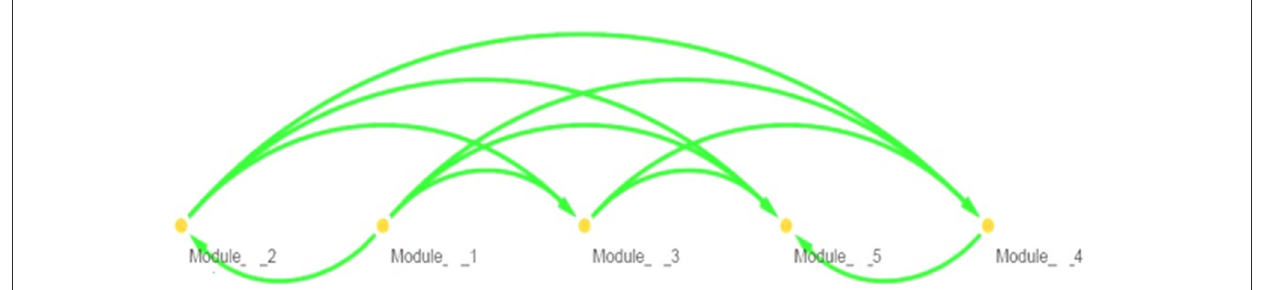
FIGURE3 Extracted molecular modules using jActiveModules.